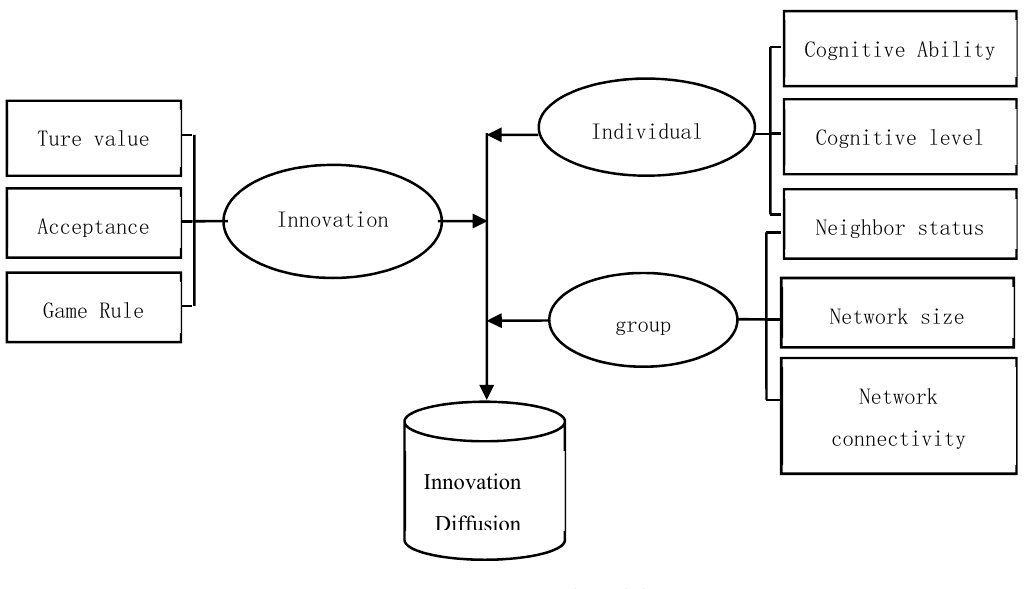
Figure 1. Conceptual model.